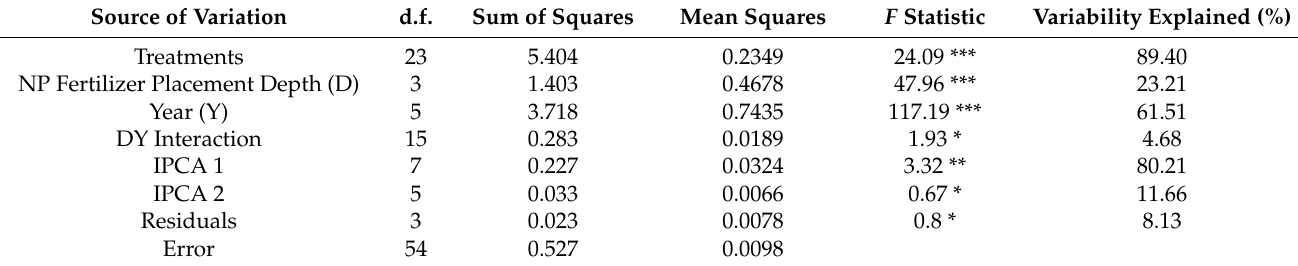
Table 3. Results of main effects and interaction from analysis of variance for the number of plants after emergence in relation to NP fertilizer placement depths as well as variability explained (in %). Coefficient of variation of the number of plants after emergence is equal to 3.28%.